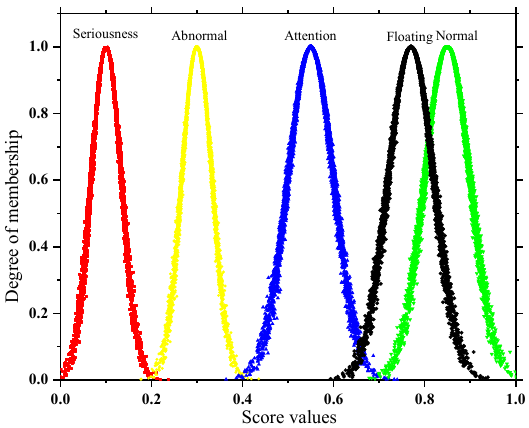
Figure 11. Membership degree of x 34.